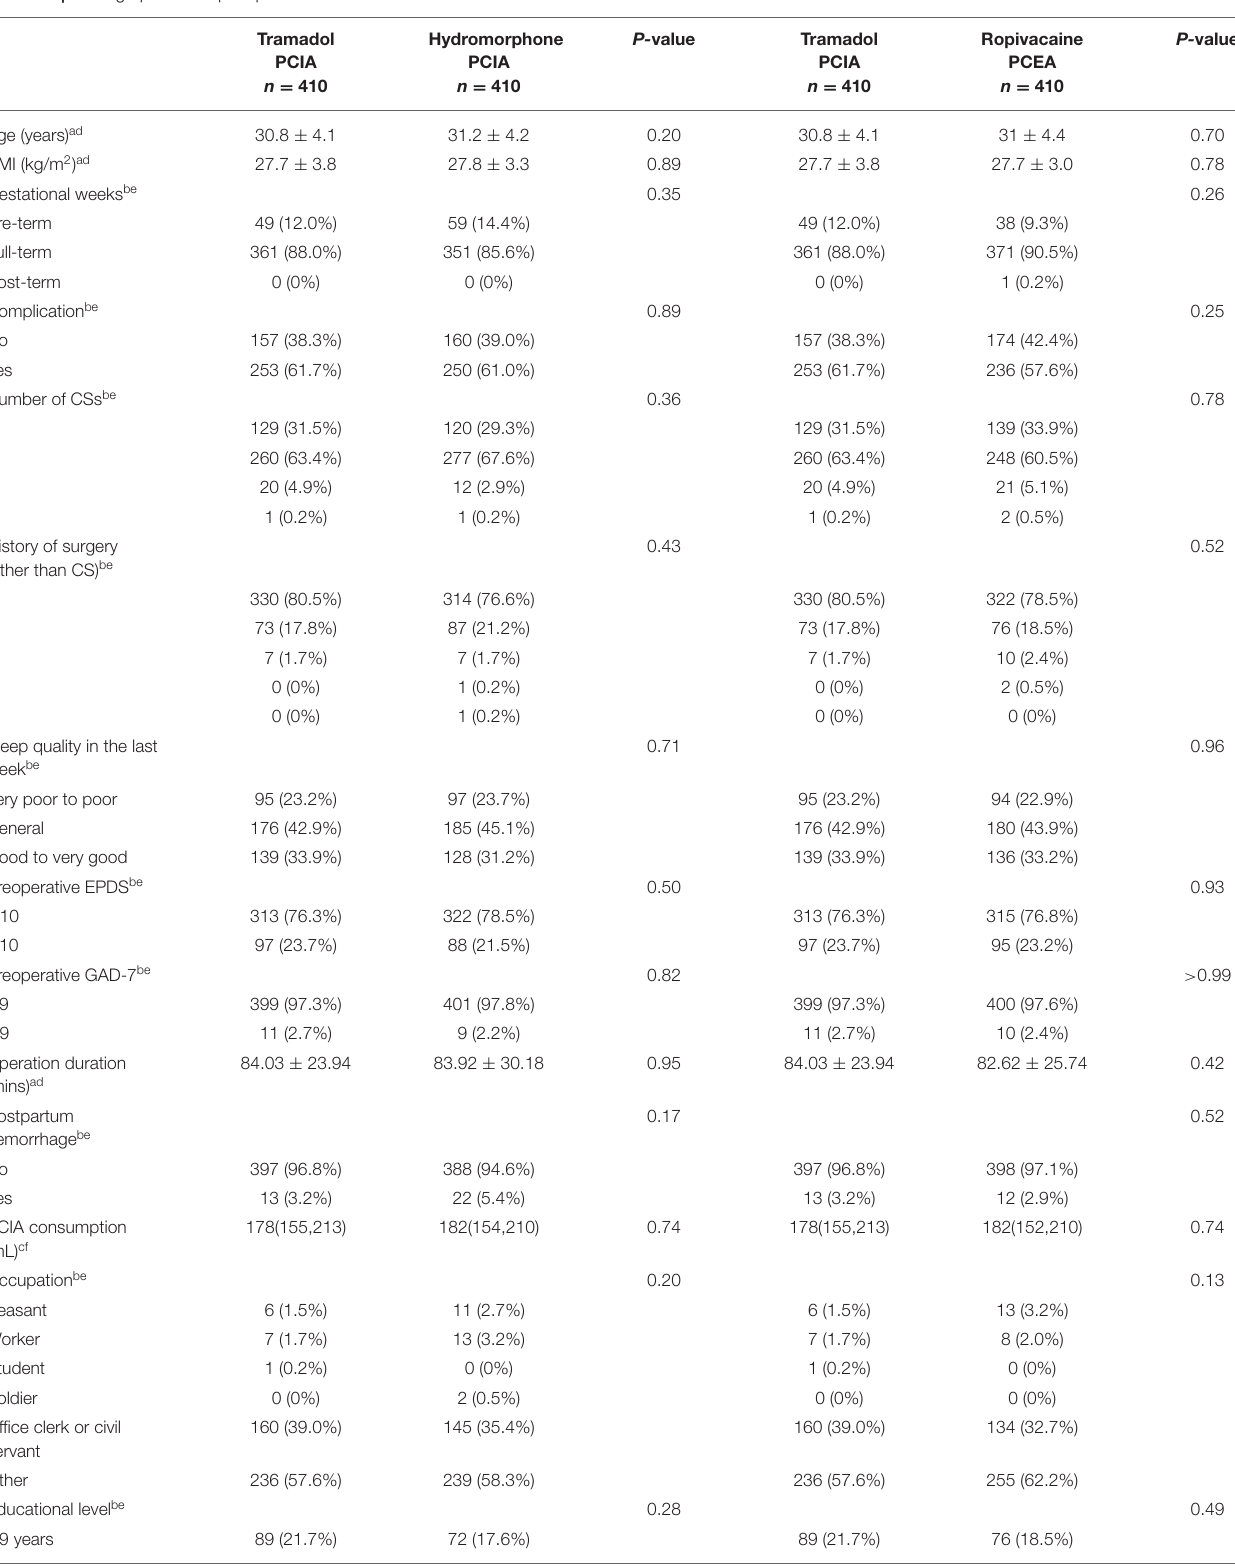
TABLE 1 | Demographics and perioperative clinical characteristics. Tramadol